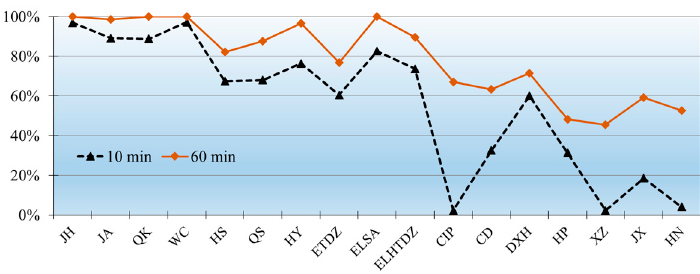
Figure 5. The proportion of the elderly population at higher- or the higest level medical accessibility in each district; capital letters in abscissa denote the abbreviations of different district in Figure 1.